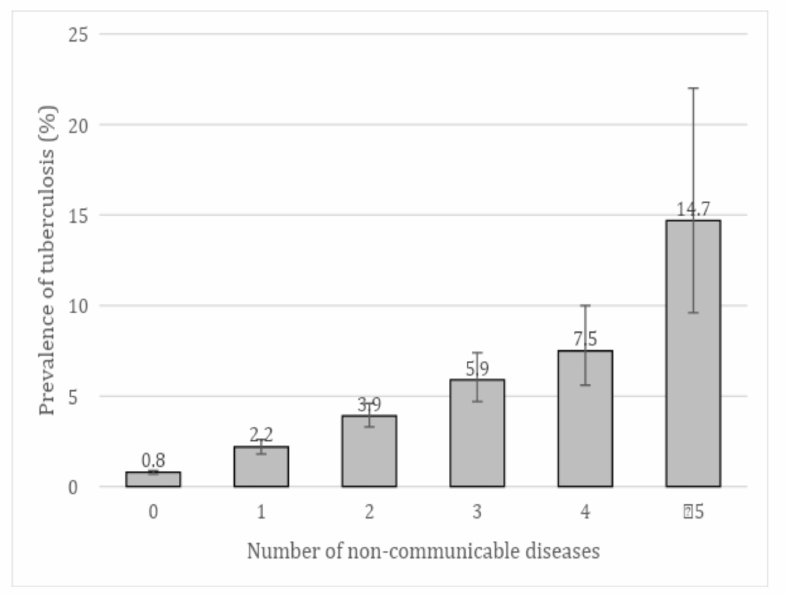
Figure A1. Prevalence of tuberculosis by number of non-communicable diseases. Bars denote 95% confidence